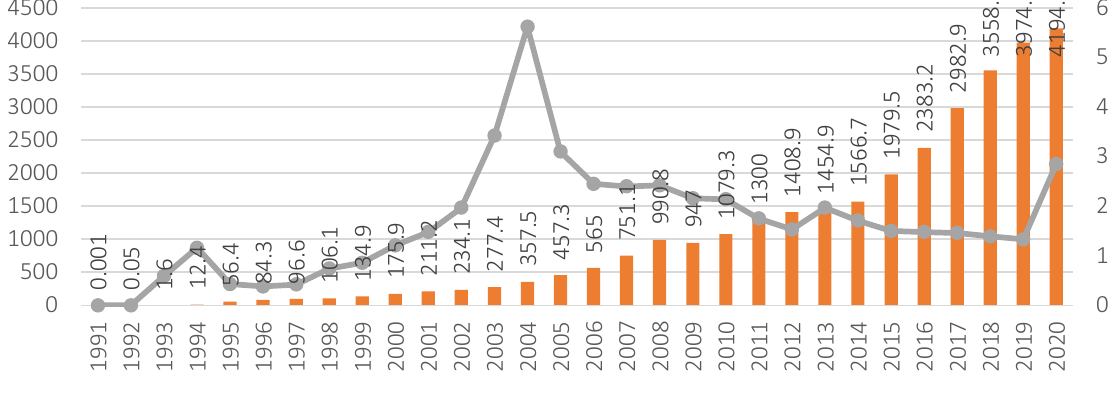
Figure 1. The volume of Ukraine’s GDP and the share of insurance penetration in GDP, 1991–2020